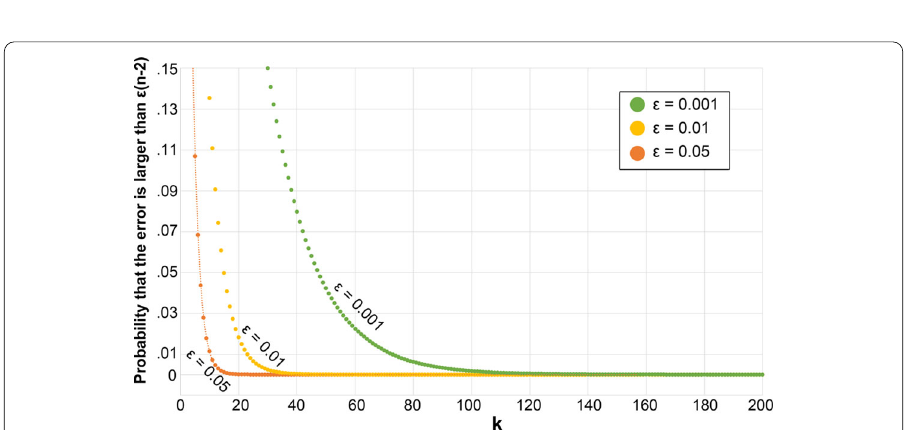
Figure 9 Probability that the error exceeds a target (depending on (cid:3) ) for different number of pivots k . Computations were performed for Cornwall